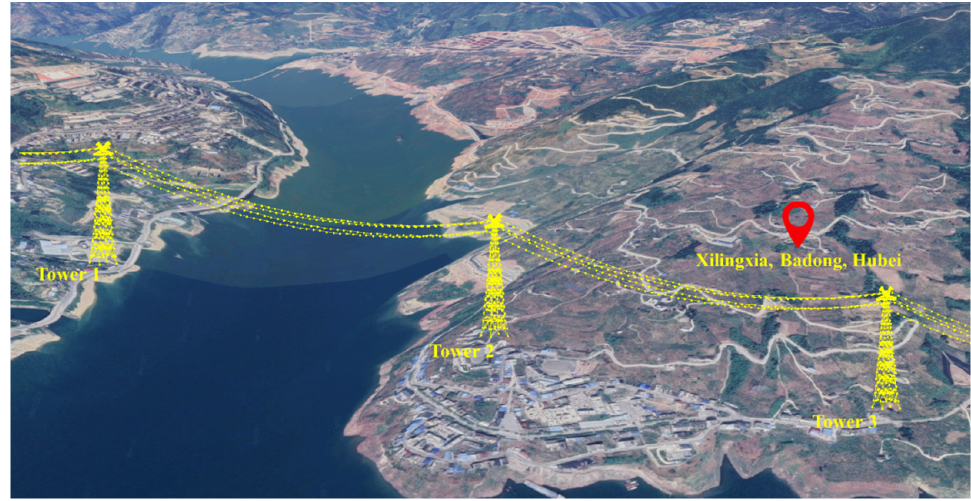
Figure 3. River-crossing transmission tower-line system (Google Maps, 17 August 2022).